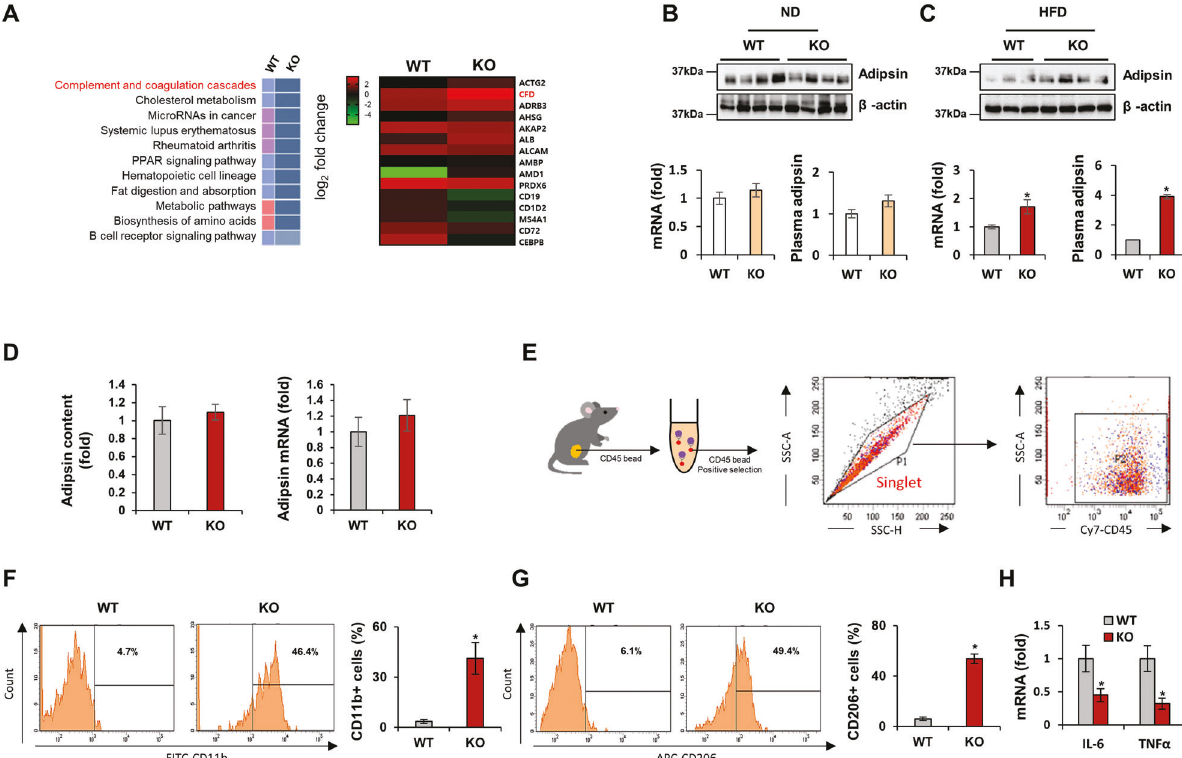
Fig. 3 TGFBI KO mice show increased adipsin expression and macrophage in fi ltration in adipose tissue. A Gene set enrichment (left) and expression heatmap (right) in iWAT obtained from 20-week-old HFD-fed WT and KO mice. B-C Adipsin expression levels were veri fi ed by performing western blot analysis (upper), qRT ‒ PCR (bottom, left), and ELISAs (bottom, right) in iWAT obtained from the ND-fed (B) and HFD- fed (C) WT and KO mice. D Secretory (left) and mRNA expression of adipsin (right) in differentiated BM-MSCs isolated from the WT and KO mice. E Cy7-CD45-positive cells were isolated from iWAT of the WT and TGFBI KO mice and identi fi ed by FACS. F-G FITC-CD11b- (F) and APC- CD206-positive (G) cells were veri fi ed and quanti fi ed (right). H Relative mRNA levels of the indicated genes in iWAT obtained from the above mice. Error bars represent the ± SEM. * p < 0.05 by two-sided t